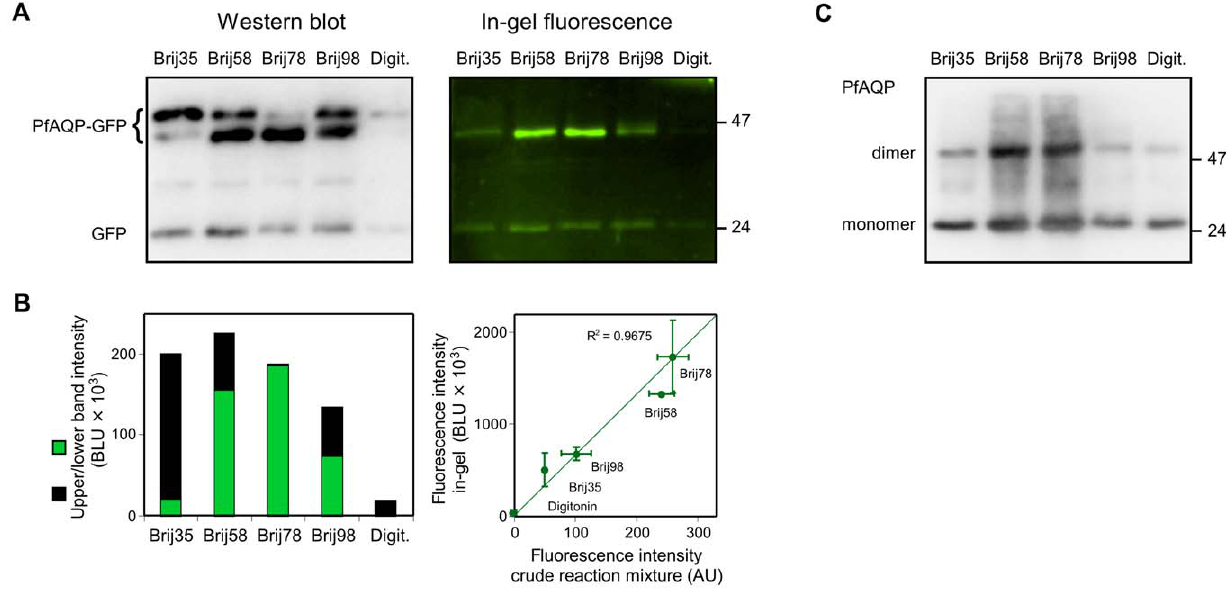
Figure 1. Cell-free synthesis of the Plasmodiumfalciparum aquaglyceroporin, PfAQP, with a C-terminal GFP shows detergent- dependent signal patterns. A . The left panel displays a Western blot of PfAQP-GFP produced in the presence of various non-ionic detergents of the Brij family and digitonin (Digit.). A polyclonal anti-GFP antiserum and a secondary horseradish peroxidase-labeled antibody were used for detection. Luminol chemiluminescence was monitored using a CCD-camera. PfAQP-GFP was obtained as two folding species with apparent molecular weights of 45 and 48 kDa. A signal representing the 24 kDa GFP domain alone was also visible. In the right panel, excitation of in-gel GFP fluorescence yielded emission signals of the 45 kDa PfAQP-GFP protein species and the 24 kDa GFP-band. B . PfAQP-GFP band intensities were determined semi-quantitatively by integration from the Western blot using arbitrary units (BLU – biomedical light units). The height of the bars in the left panel represents the total protein yield as a sum of the signals from the upper 48 kDa band (black) and the lower 45 kDa band (green). The plot in the right panel confirms correlation of the in-gel GFP fluorescence signal with GFP fluorometry of the crude cell-free reaction mixture. Intensity units given by the fluorometer are arbitrary (AU). The symbols and error bars denote mean values and the data range from two independent synthesis reactions and fluorometric evaluations. C . Cell-free synthesis, SDS-PAGE, and Western blot of non-fused PfAQP yielded signals for the monomer ( < 25 kDa) and the dimer using an anti-His 5 antiserum. A semi-quantitative representation of the protein yield is shown in Fig. S3. Most stable dimers were obtained with Brij58 and Brij78, which also led to highest in-gel fluorescence intensity.